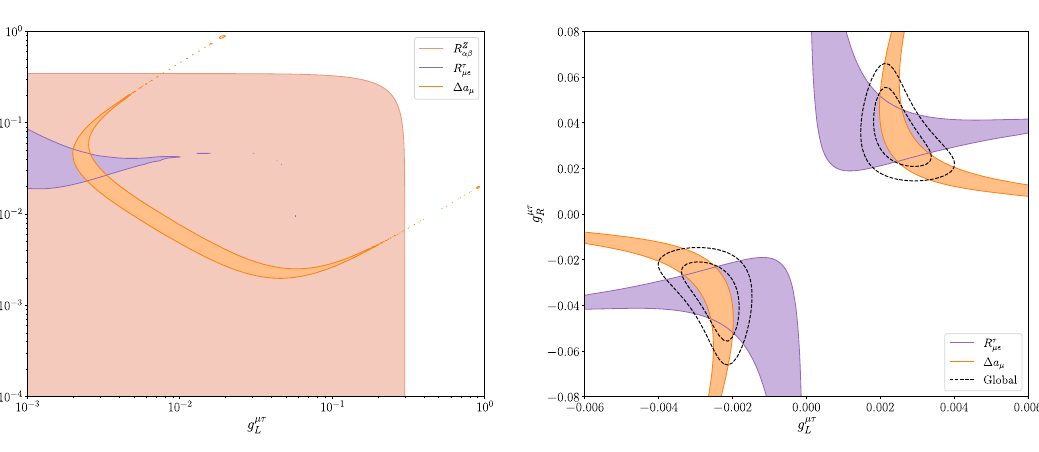
Fig. 4 Constraints on Z (cid:2) couplings, g Ontheleft,allowedregimesfor (cid:2) a μ inthesame-sign( g eter space, in agreement with the experimental bounds on LFU Z decay